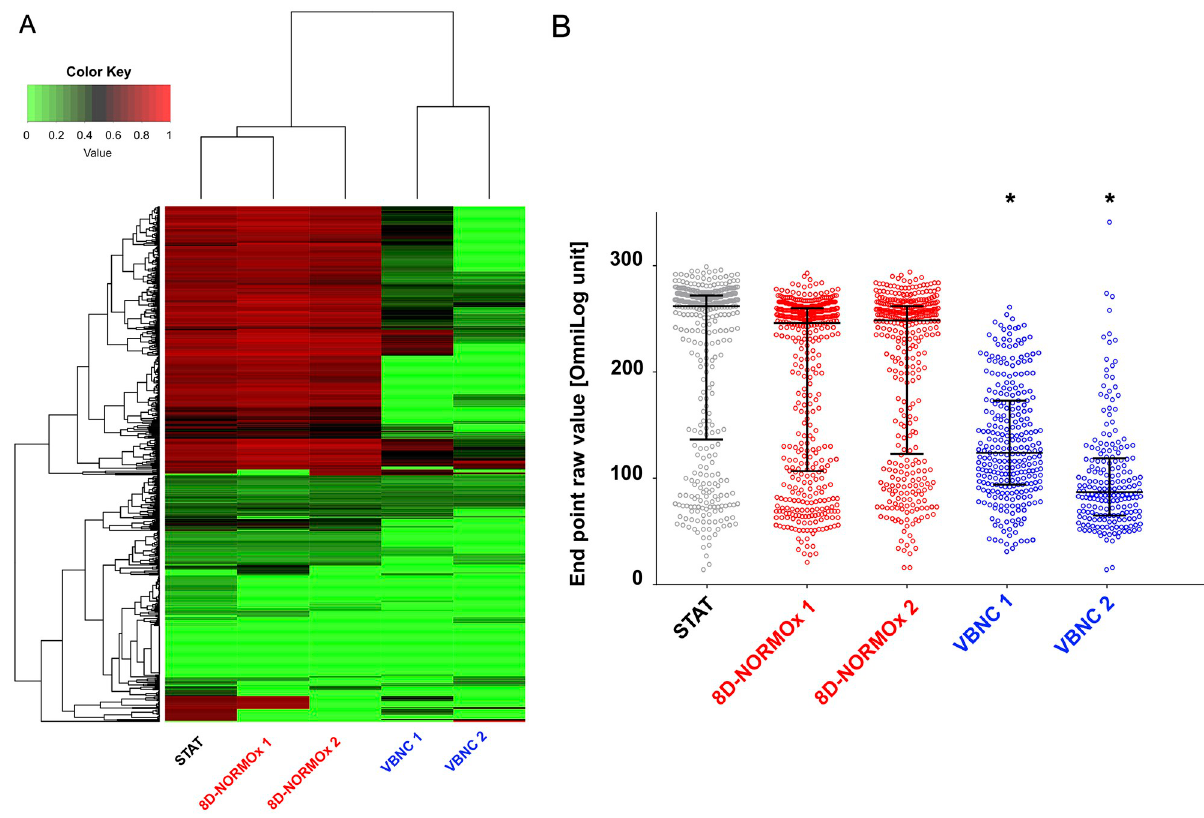
Fig 4. Phenotypic array analysis of VBNC showed a lower metabolic activity. We used the Biolog technology to explore the metabolic requirements of VBNC compared to STAT and 8D-NORMOx cells. We selected 8 plates and 761 different metabolites to scan the ability of substrates to be used as an energetic source. The respiratory activity (measurement of tetrazolium reduction in arbitrary units) was compared at the end of the incubation (6 days). Two biological replicates (1 and 2) were done for the VBNC/8D-NORMOx conditions. A . The heatmap of 521 selected compounds showed that VBNC exhibited a different metabolic profile than STAT and 8D-NORMOx. Color key corresponds to the normalized value of the OD between 0 and 1. B . The final endpoint analysis of the level of tetrazolium reduction (colorimetric change in tetrazolium dye or Omnilog unit, equivalent of the Optical Density measured at 590nm) revealed a lower activity for VBNC cells compared to cells in other conditions. VBNC and 8D-NORMOx conditions were done in duplicate ( � p < 0.01).